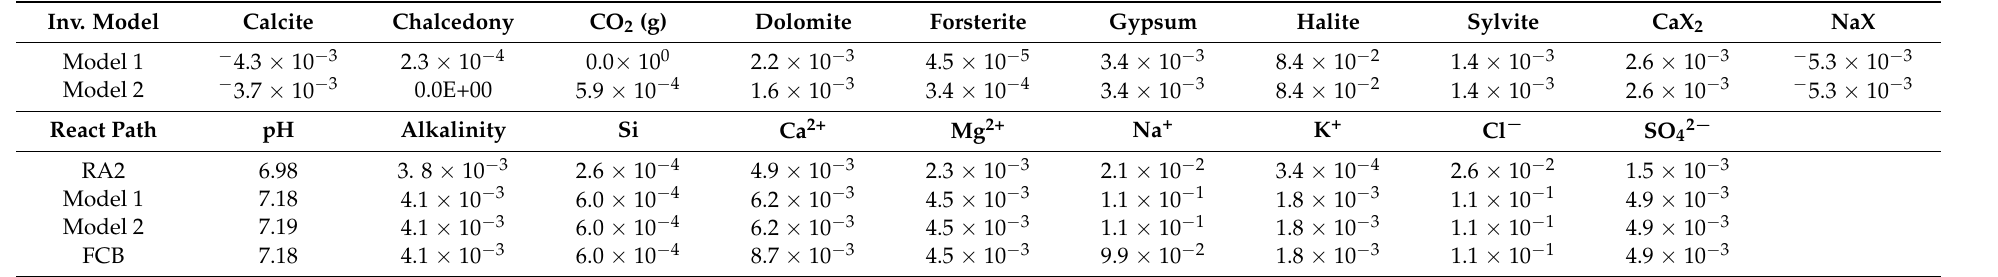
Table 6. Results of the inverse modeling applied to RA2 (as initial solution) and FBC (as final solution) waters: phases obtained for the best-fit models and composition of the water considering the dissolution/precipitation of the phases. Units are in moles for the solid phases and molality for dissolved species. Inv.